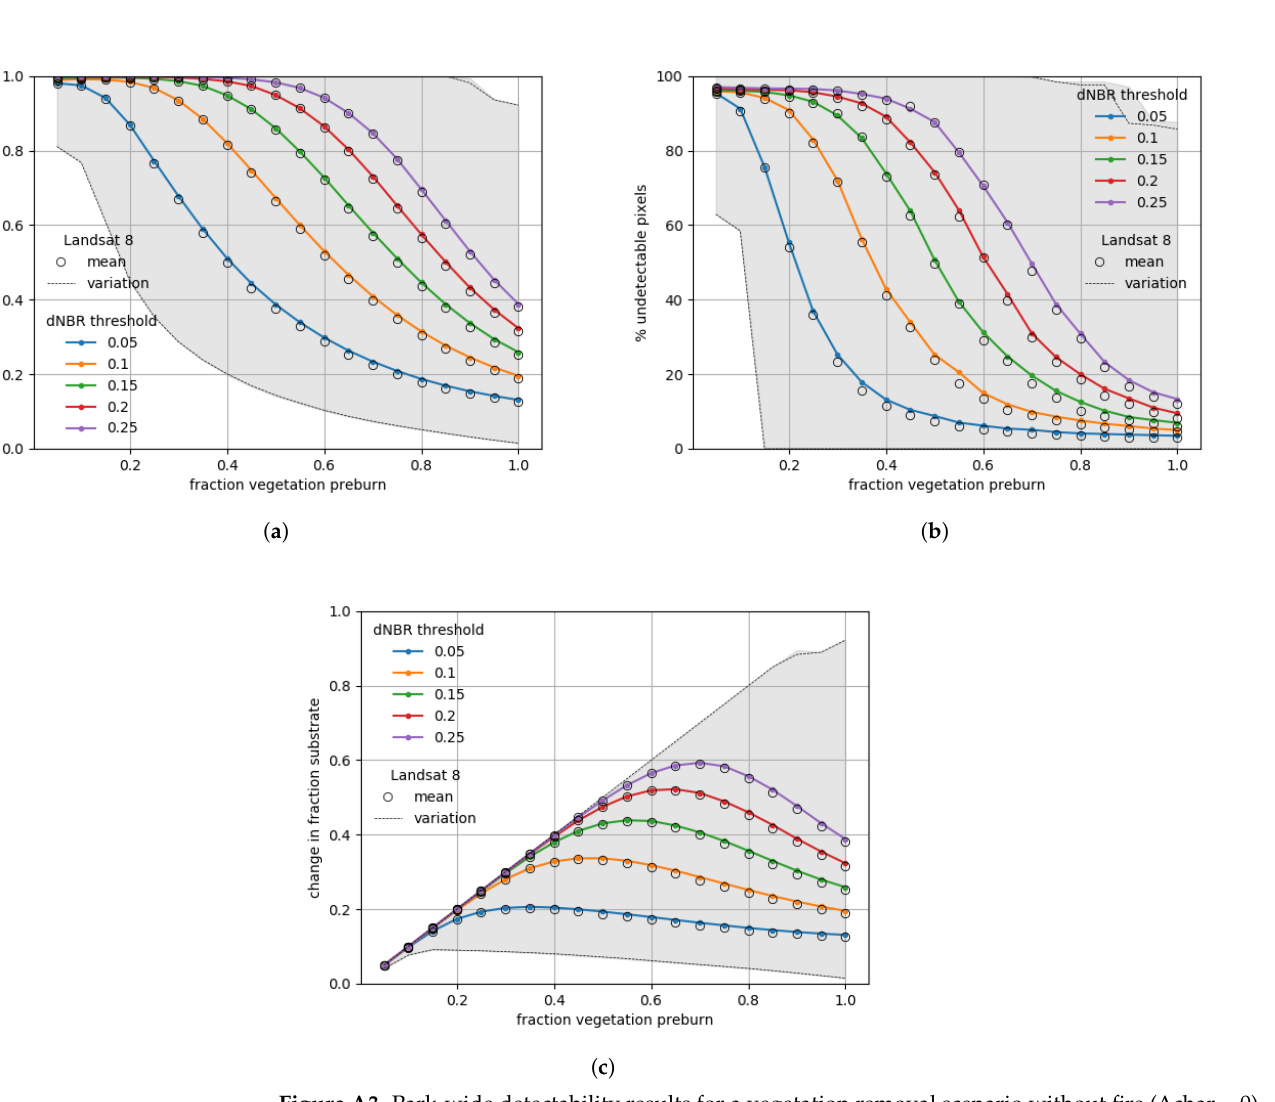
Figure A3. Park-wide detectability results for a vegetation removal scenario without fire ( ∆ char = 0), Sentinel-2A. The mean values are shown in colored lines, with total model result variation shown in gray. To compare, the results for Landsat 8 are shown in black, with mean values shown by circles and total model result variation shown by dashed lines. ( a ) Fraction of vegetation burned at detection. ( b ) Percentage of undetectable pixels. ( c ) Increase in substrate fraction on